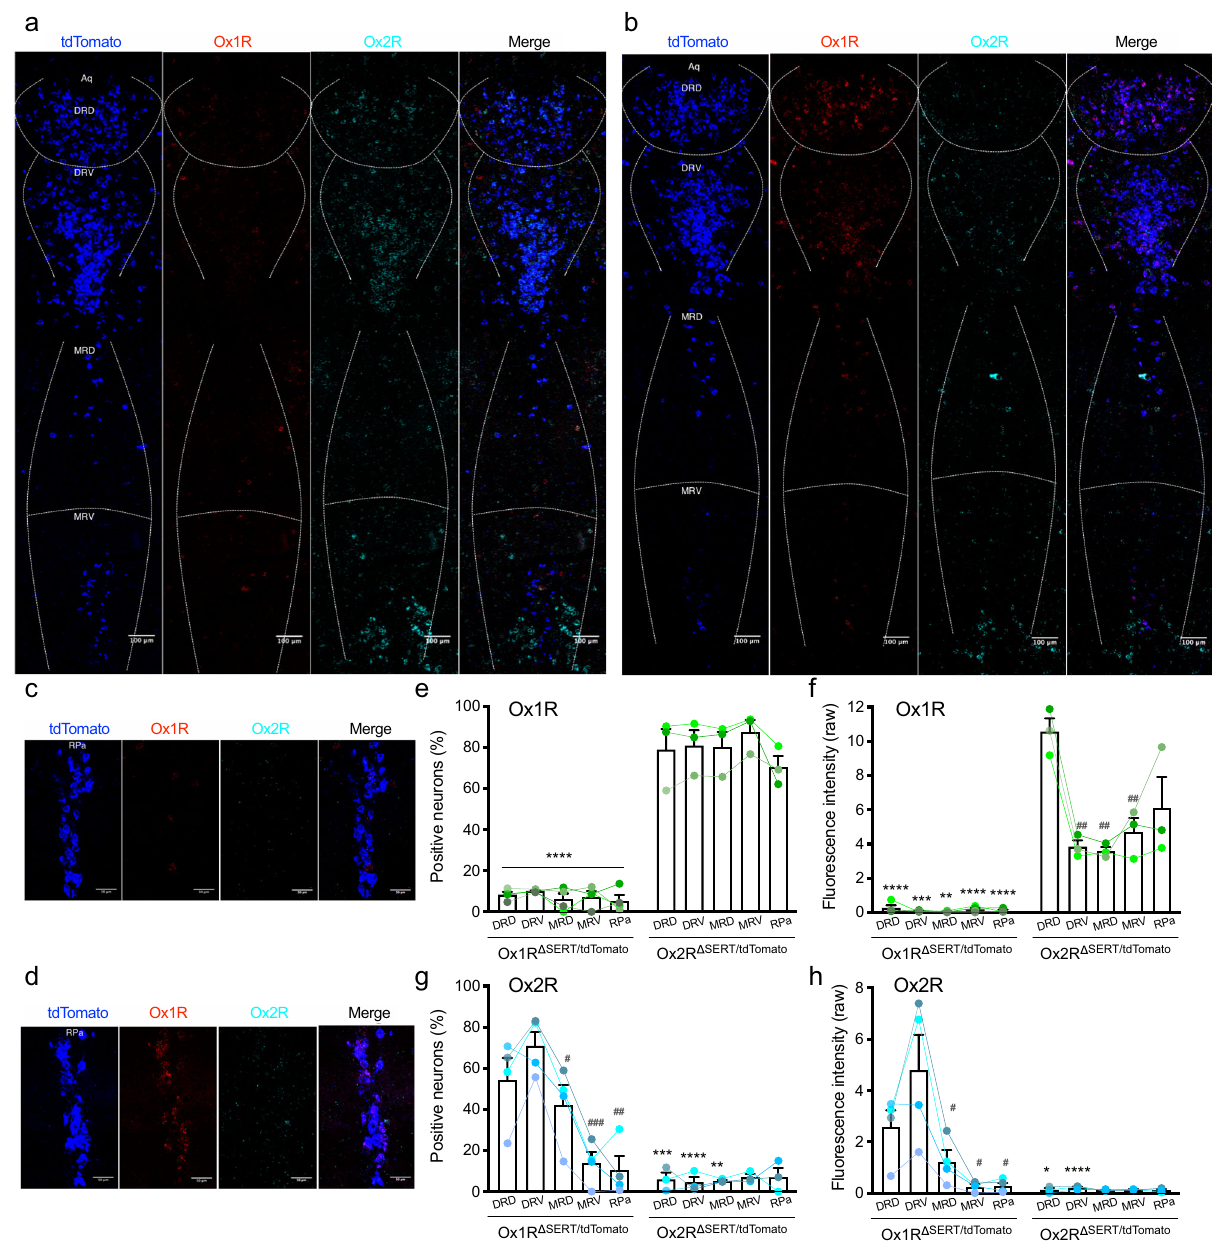
Fig. 2 Speci fi c inactivation of Ox1R or Ox2R in serotonergic neurons of a Ox1R Δ SERT/tdTomato or Ox2R Δ SERT/tdTomato mouse, respectively. a Representative images of RNAscope in situ hybridization in the dorsal raphe nucleus (dorsal (DRD), ventral (DRV)) and median raphe nucleus (dorsal (MRD), ventral (MRV)) of a Ox1R Δ SERT/tdTomato mouse and b a Ox2R Δ SERT/ tdTomato mouse. c Representative images of RNAscope in situ hybridization in the raphe pallidus (RPa) of a Ox1R Δ SERT/tdTomato mouse and d a Ox2R Δ SERT/tdTomato mouse. e , g Percentages of Ox1R or Ox2R positive neurons in serotonergic neurons. f , h The average of raw fl uorescence intensity of Ox1R or Ox2R signal in each serotonergic neuron. Blue, tdTomato; red, Ox1R; cyan, Ox2R. Scale bar: 100 µ m in ( a , b ) and 50 µ m in ( c , d ). Ox1R Δ SERT/tdTomato , n = 4; Ox2R Δ SERT/tdTomato , n = 3. Data are represented as means±SEM. f Ox1R Δ SERT/ tdTomato : p = 0.0005 (DRV) and 0.0011 (MRD); Ox2R Δ SERT/ tdTomato : p = 0.0041 (DRV), 0.0088 (MRD) and 0.0098 (MRV). g Ox1R Δ SERT/ tdTomato : p = 0.013 (MRD), 0.0006 (MRV) and 0.0014 (RPa); Ox2R Δ SERT/ tdTomato : p = 0.0002 (DRD) and 0.0046 (MRD). h Ox1R Δ SERT/ tdTomato : p = 0.038 (MRD), 0.039 (MRV) and 0.037 (RPa); Ox2R Δ SERT/tdTomato : p = 0.037 (DRD). * p <0.05, ** p <0.01, *** p <0.001, **** p <0.0001; as determined by two-way ANOVA followed by Sidak ’ s post hoc test. The main effect of genotype: e ( F (1, 25) = 583.60, p <0.0001), f ( F (1, 25) = 234.20, p <0.0001), g ( F (1, 25) = 53.99, p <0.0001), h ( F (1, 25) = 20.08, p = 0.0001). # p <0.05, ## p <0.01, ### p <0.001, compared to DRD ( f ) or DRV ( g , h ), as determined by paired two-tailed t -test. Source data are provided as a Source Data fi